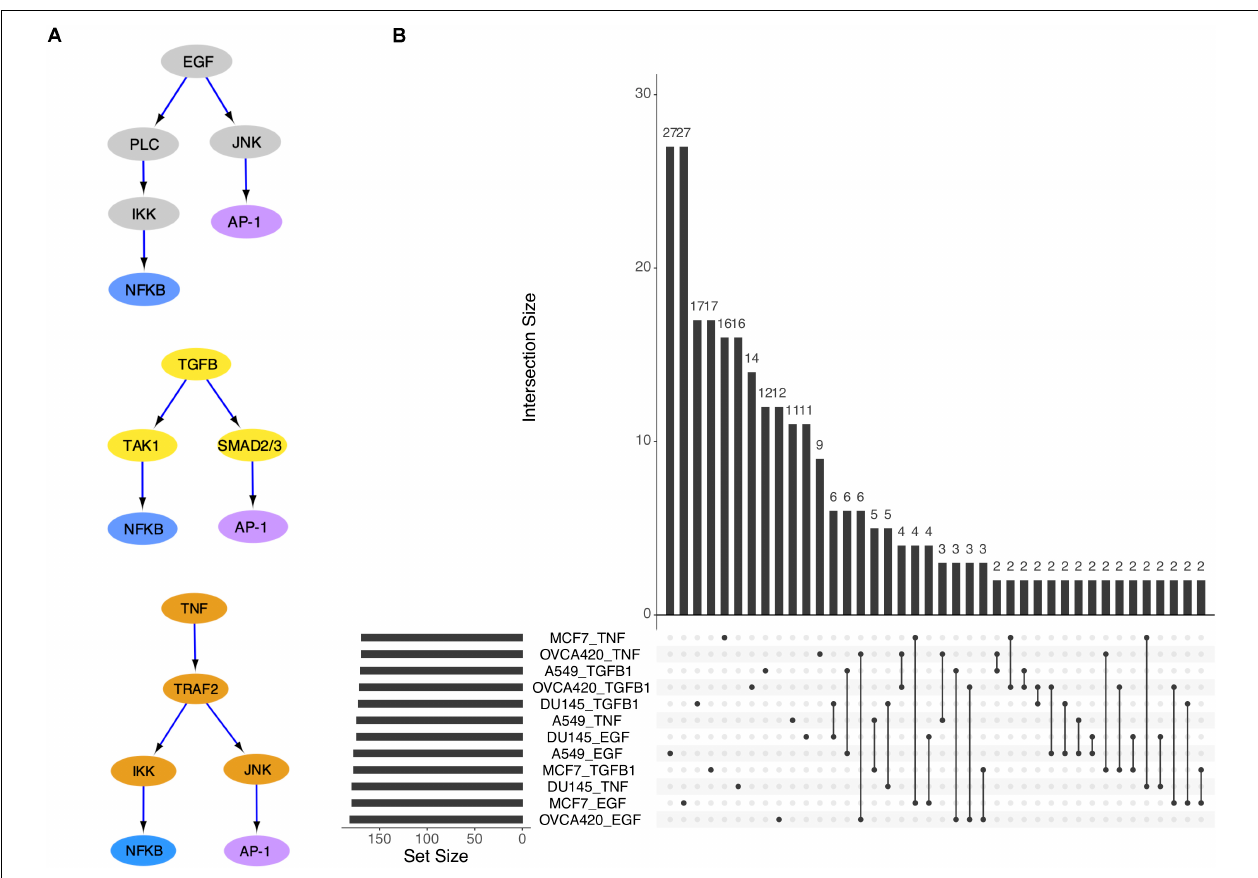
FIGURE 2 | The three signal pathways have convergent gene targets. (A) Simplified models of signal transduction pathways for EGF, TGFB1, and TNF based on published results in the literature. (B) Upset plot showing overlap of differentially activated regulons across cell lines and signal treatments.